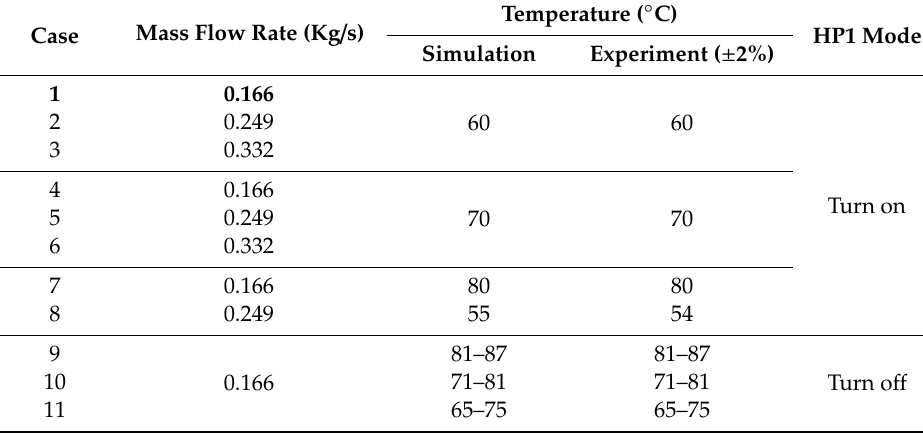
Table 2. Operating conditions of hot water inlet for the heat exchanger.